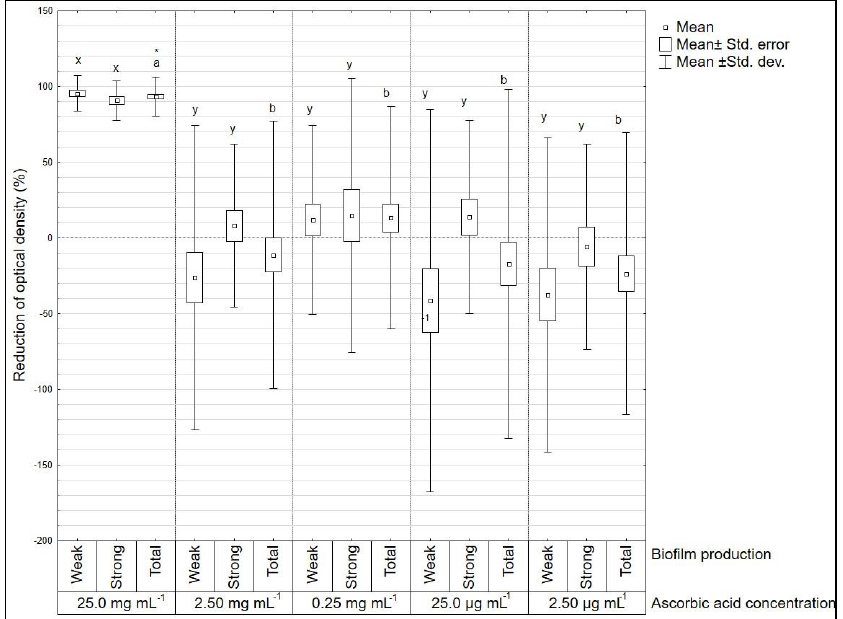
Figure 3. Reduction of optical density (%) after ascorbic acid treatment on Escherichia coli ( n = 16) strains. Amongst all strains n = 9 were defined as weak biofilm producers and n = 7 as strong biofilm producers. Letters a, b mark statistically significant differences between different concentrations (all strains included). Letters x, y mark statistically significant differences between groups of strong and weak biofilm producers ( p < 0.05). * Statistically significant difference between certain ascorbic acid concentration and positive control (marked with horizontal line, value “0” on y axis)